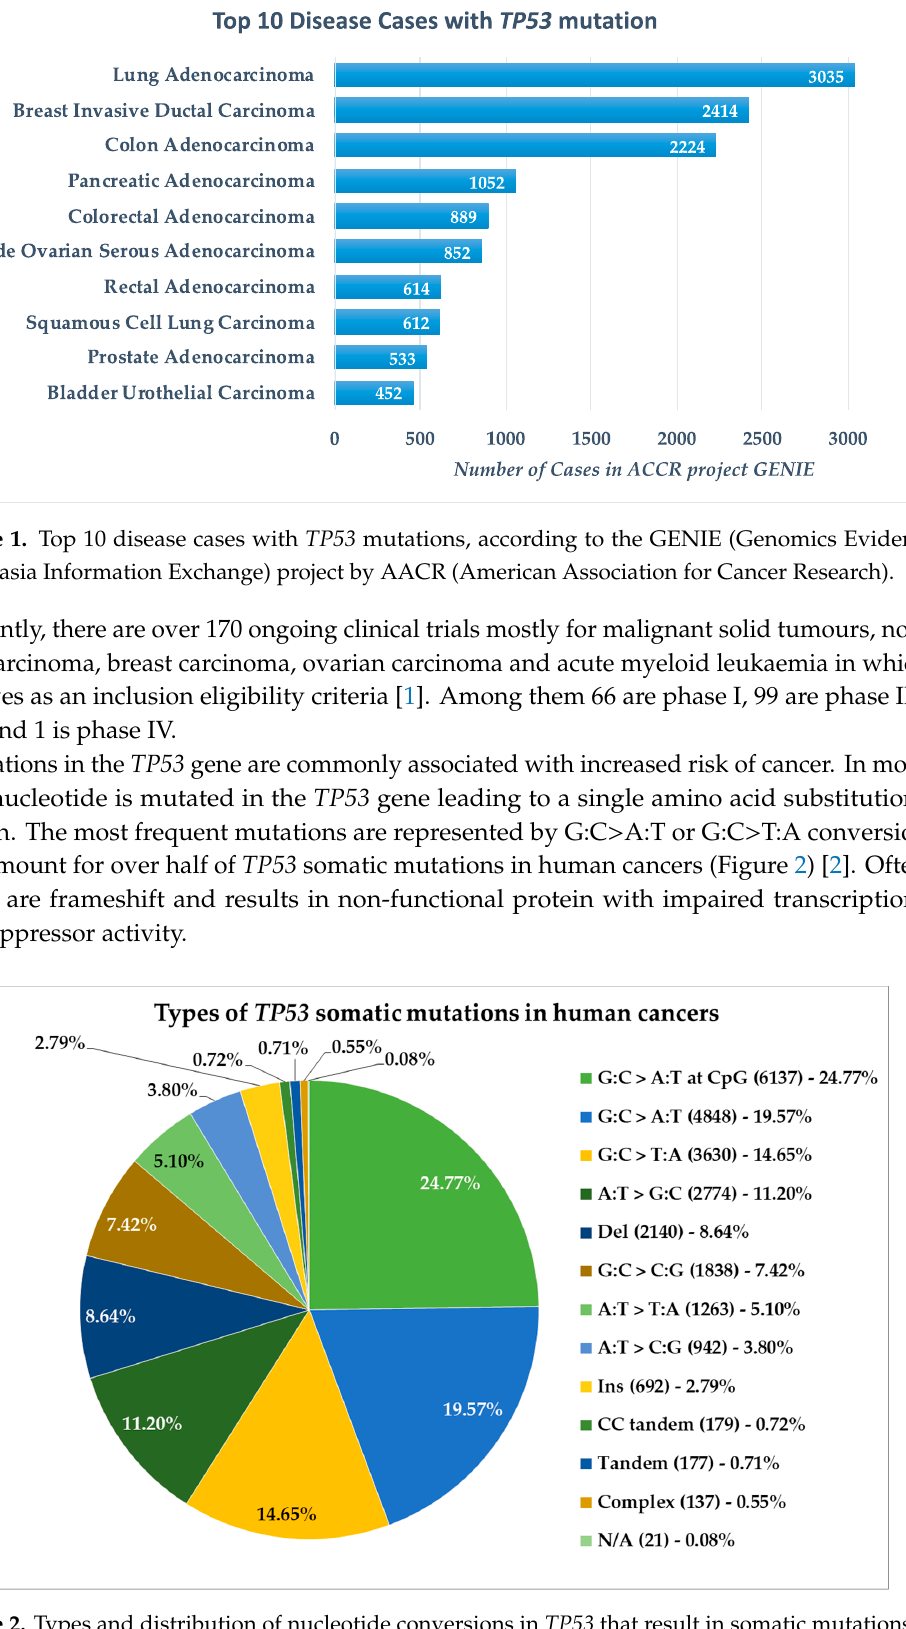
Figure 2. Types and distribution of nucleotide conversions in TP53 that result in somatic mutations in human cancers, according to the IARC (International Agency for Research on Cancer) TP53